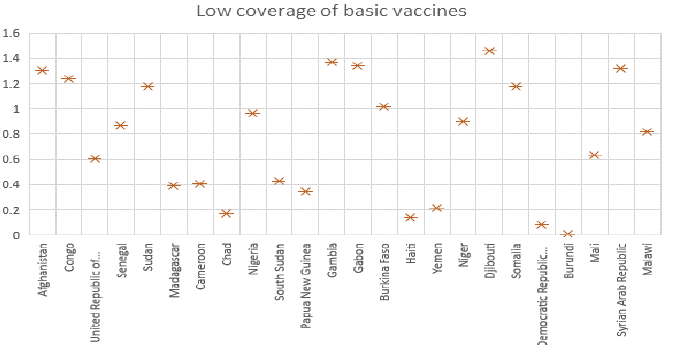
Figure 6. The basic vaccination rates of 24 countries with low vaccination rates.